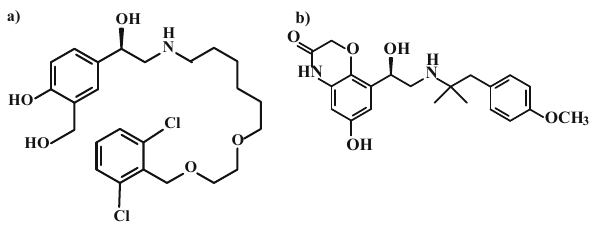
Figure 14: Chemical structure of ( a ) vilanterol and ( b ) olodaterol.